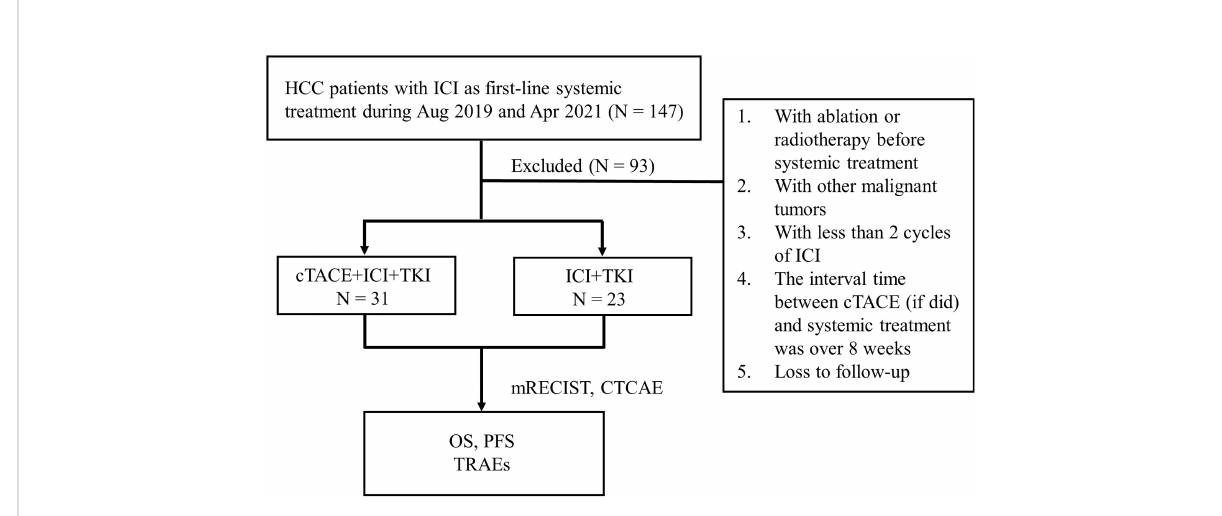
FIGURE 1 Flowchart of this